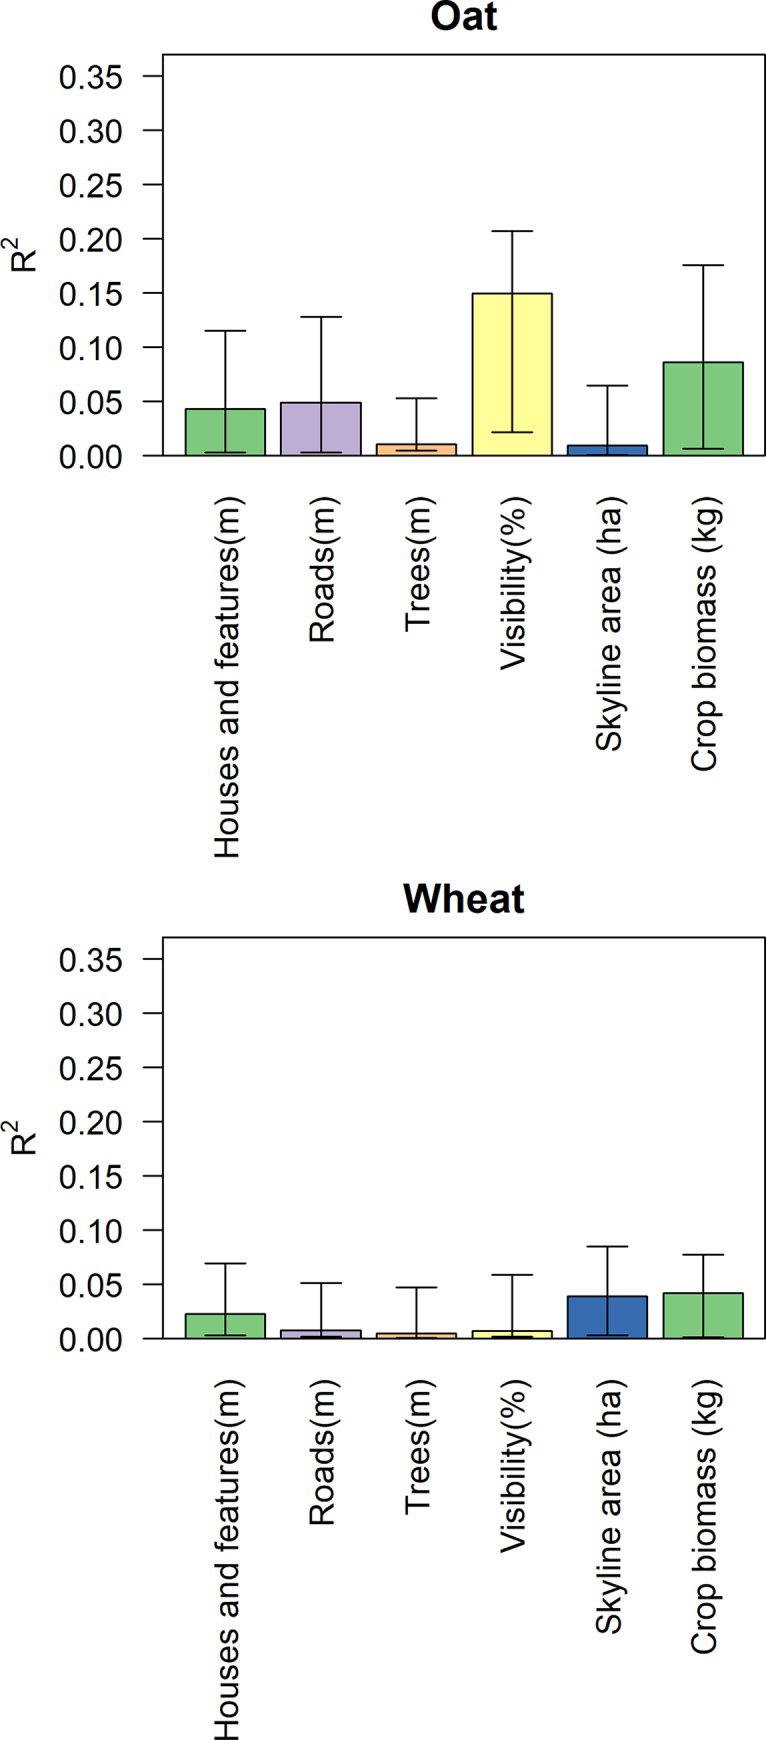
The decomposition of the importance of the multiple linear regression.Correlation is expressed here as absolute R2 values. Bars represent the explained part of the grazing pressure (as described by Eq 1) by each parameter expressed in relative weight, lines represent the error of the estimate.